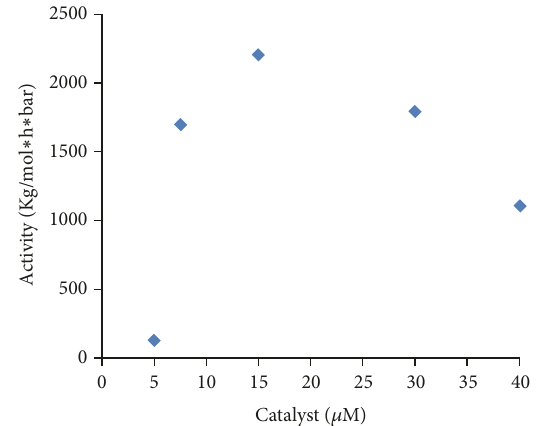
Figure 2: Catalyst activity versus catalyst concentration for poly- merizations run in